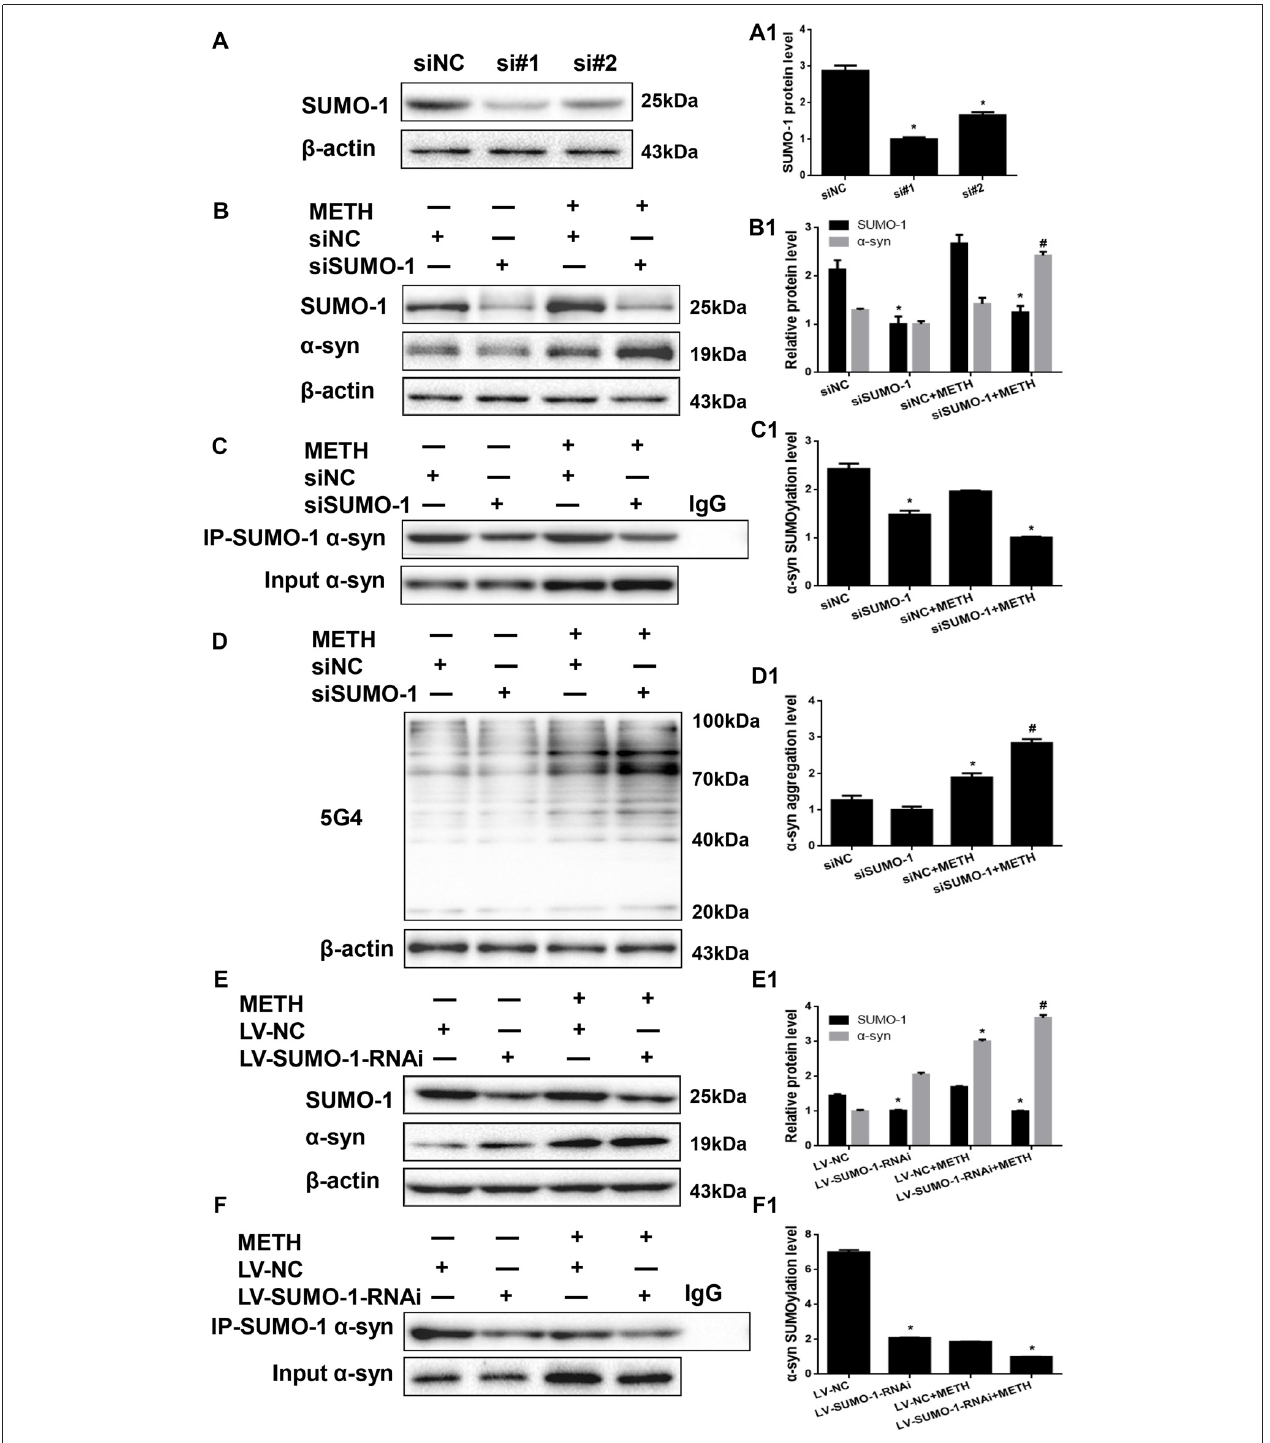
FIGURE 5 | Silencing of SUMO-1 expression exacerbates α -syn aggregation in METH-treated cells. First, SH-SY5Y cells were transfected with siNC, siSUMO-1#1 or siSUMO-1#2 (A) . Then, SH-SY5Y cells (B–D,B1–D1) and primary cultured neurons (E,F,E1,F1) were transfected with siNC or siSUMO-1 and LV-NC or LV-SUMO-1-RNAi, respectively and the cells were treated with or without METH. The cells were immunoprecipitated with an anti-SUMO-1 antibody, followed by western blot with an anti- α -syn antibody. Cells were immunoprecipitated with IgG were used as a negative control. Western blot (A–F) and quantitative analyses (A1–F1) were performed to evaluate the expression of SUMO-1 and the expression, aggregation and SUMOylation of α -syn. β -Actin was used as a loading control. ∗ p < 0.05 compared with the NC group. # p < 0.05 compared with the METH-treated NC group. The data were analyzed using one-way ANOVA followed by LSD post hoc